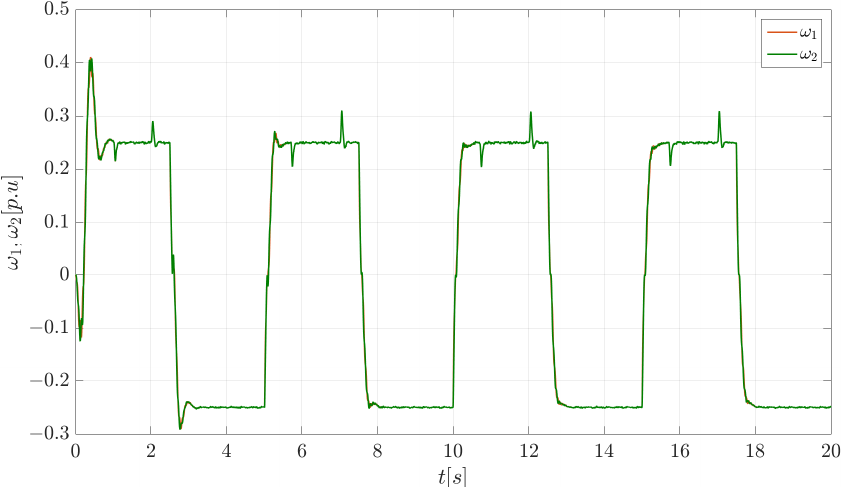
Figure 19. Results from the experimental setup obtained after increasing the value of the learning